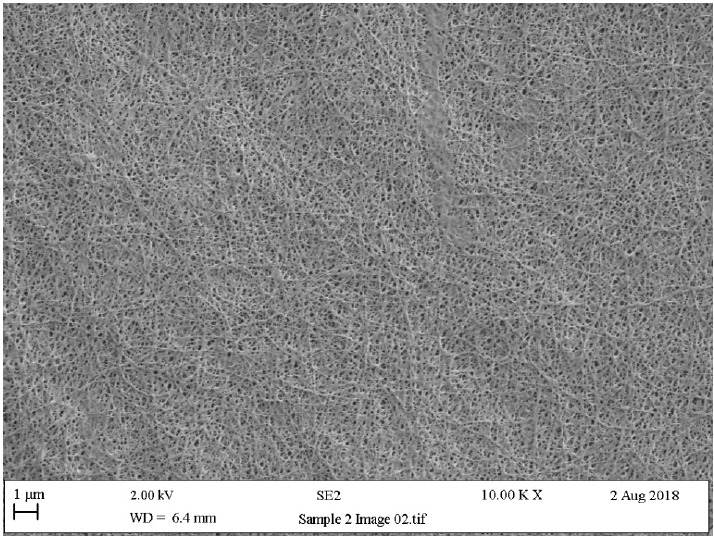
Figure 3. Scanning electron microscopy image of a dried bacterial cellulose biofilm (10,000× magnification).